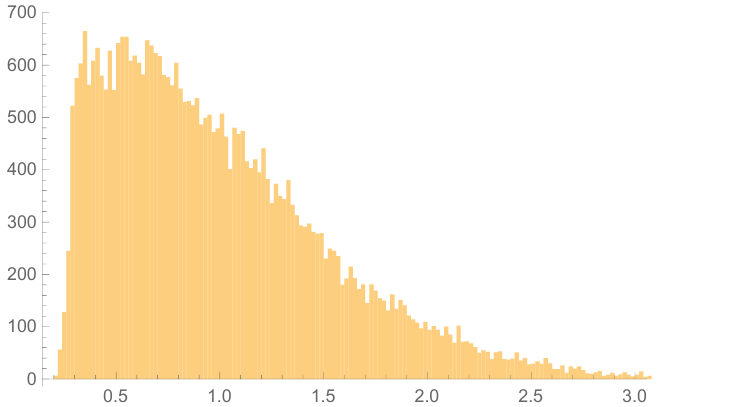
Figure 16 . The ratio of the distances between nearest eigenvalues for the upper block of the GW hamiltonian.